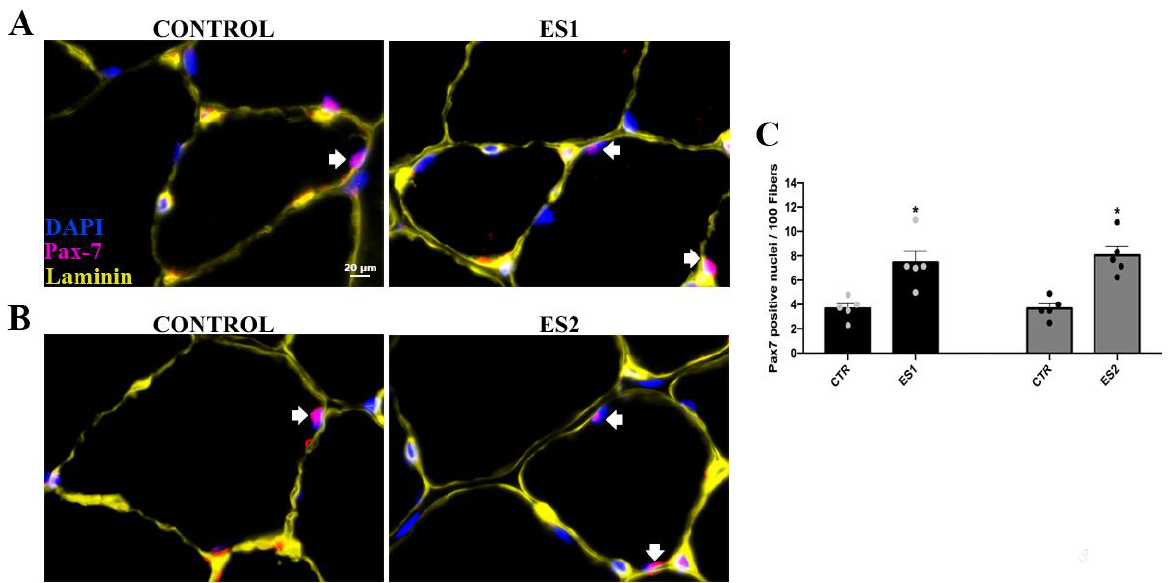
Figure 4. Analysis of Pax-7 positive cell counts after one and two weeks of electrical stimulation. ( A , B ) Representative immunofluorescence micrographs of DAPI (blue, used to identify nuclei), Pax-7 (violet), and Laminin (yellow) after one and two weeks, respectively, of electrical stimulation (20 µm scale bar). ( C ) The number of positive Pax-7 nuclei per 100 fibers after one and two weeks, re- spectively, of electrical stimulation (n = 5 per group). The arrows indicate Pax-7 positive cell. The data are presented as mean ± SD. Two-way ANOVA was followed by Tukey ’ s post-test in the sta- tistical analysis. * p < 0.0001 in comparison to the relevant control group throughout time.